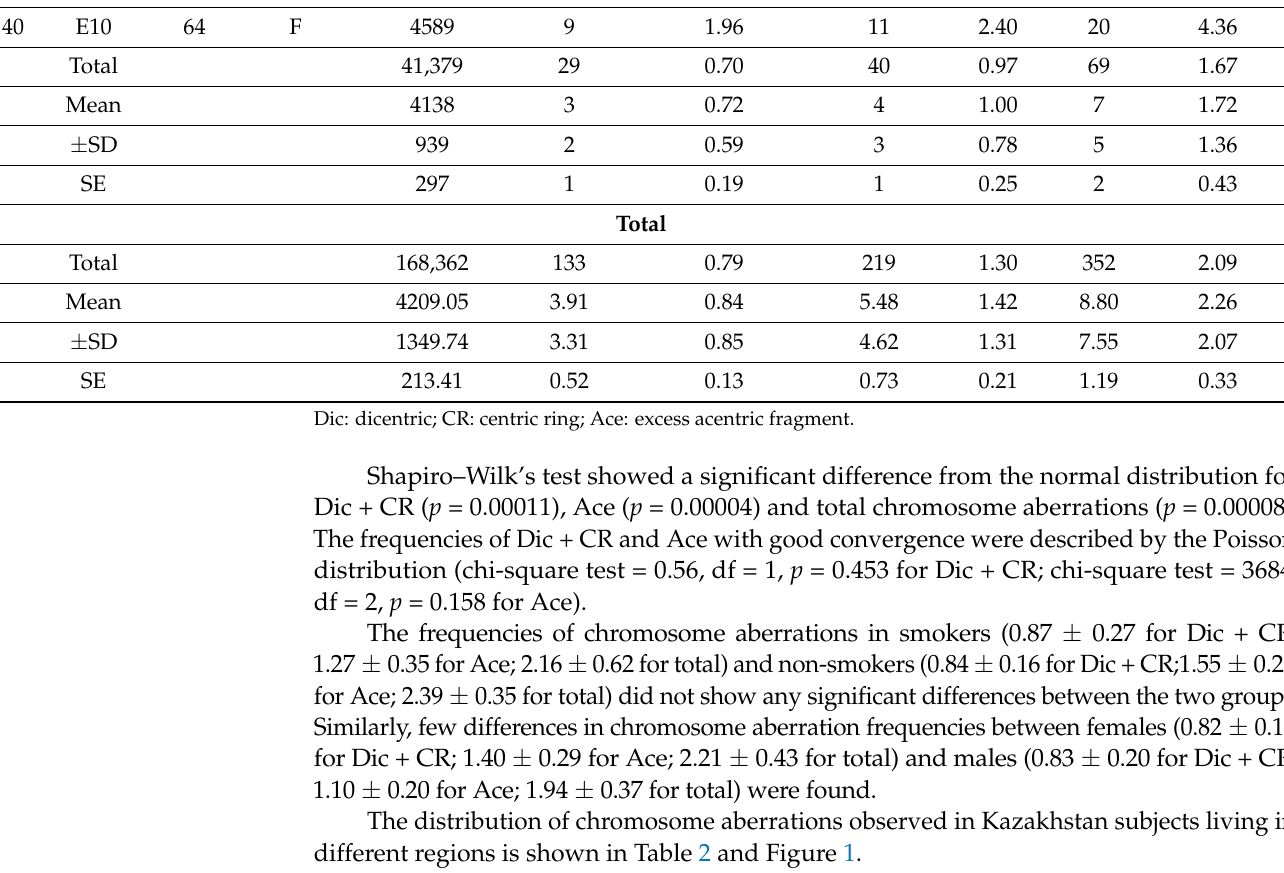
Table 2. Chromosome aberration yield in subjects living in different regions of